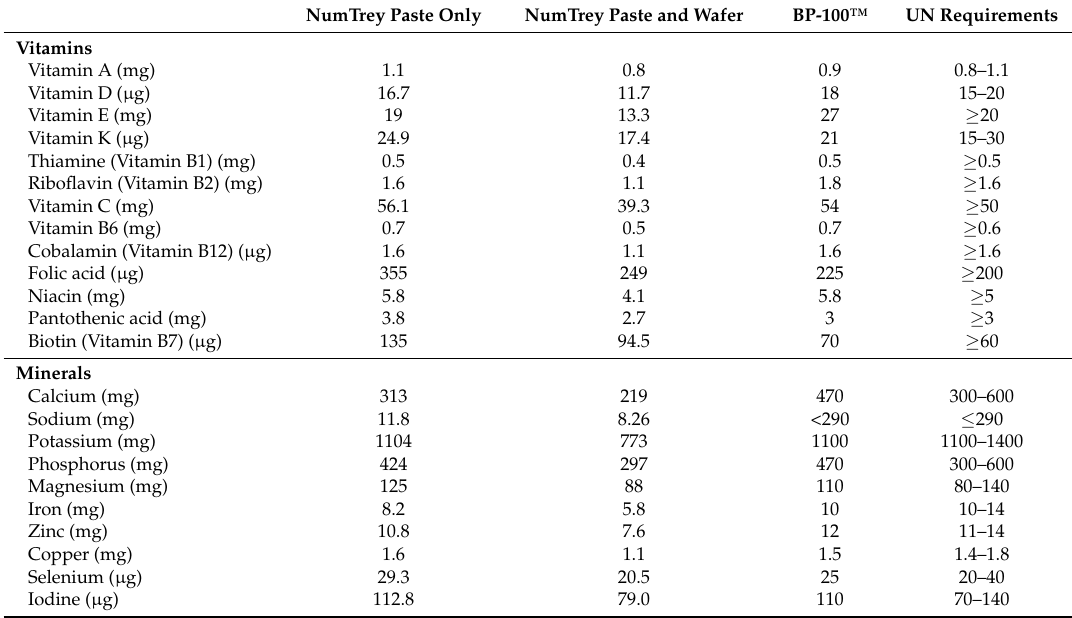
Abbreviations: UN = United Nations. Table 2. Distributed food ration of BP-100 TM and NumTrey based on patient’s